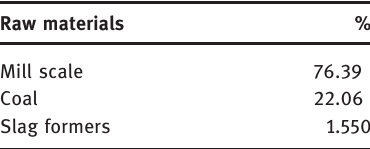
Table 1: The contents of raw materials (%).